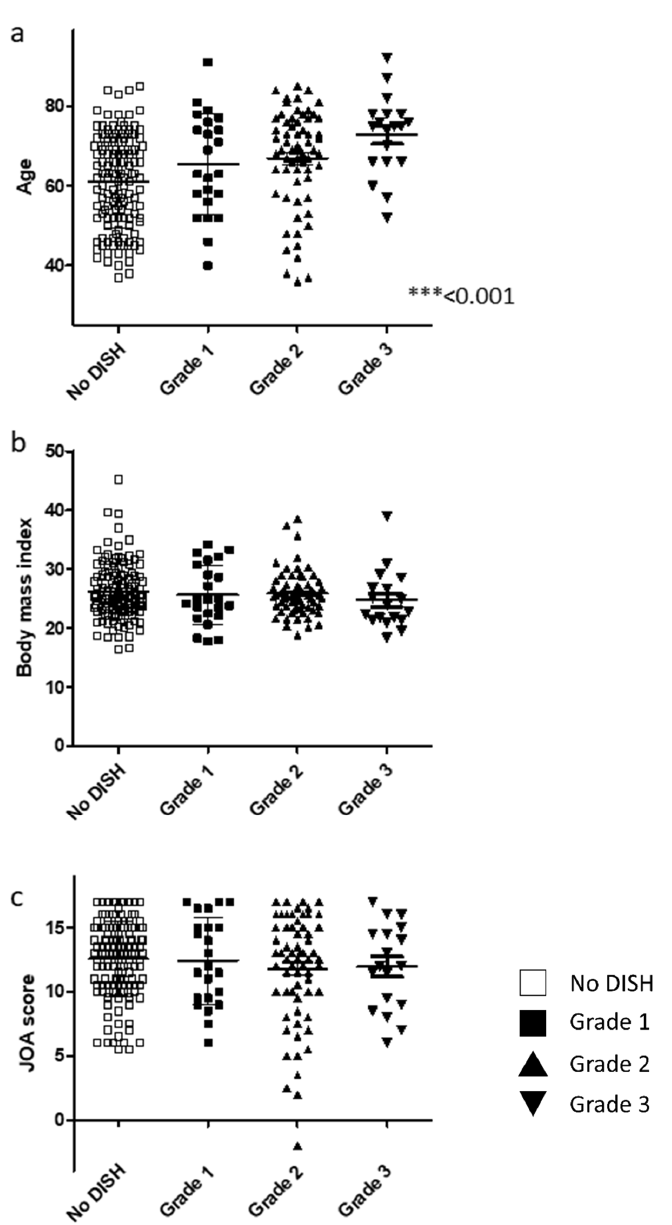
Figure 2. Relationship between basic demographic and clinical findings and DISH grade. ( a ) Patient age. ( b ) Body mass index. ( c ) JOA score. DISH, diffuse idiopathic skeletal hyperostosis; JOA, Japanese Orthopaedic Association.